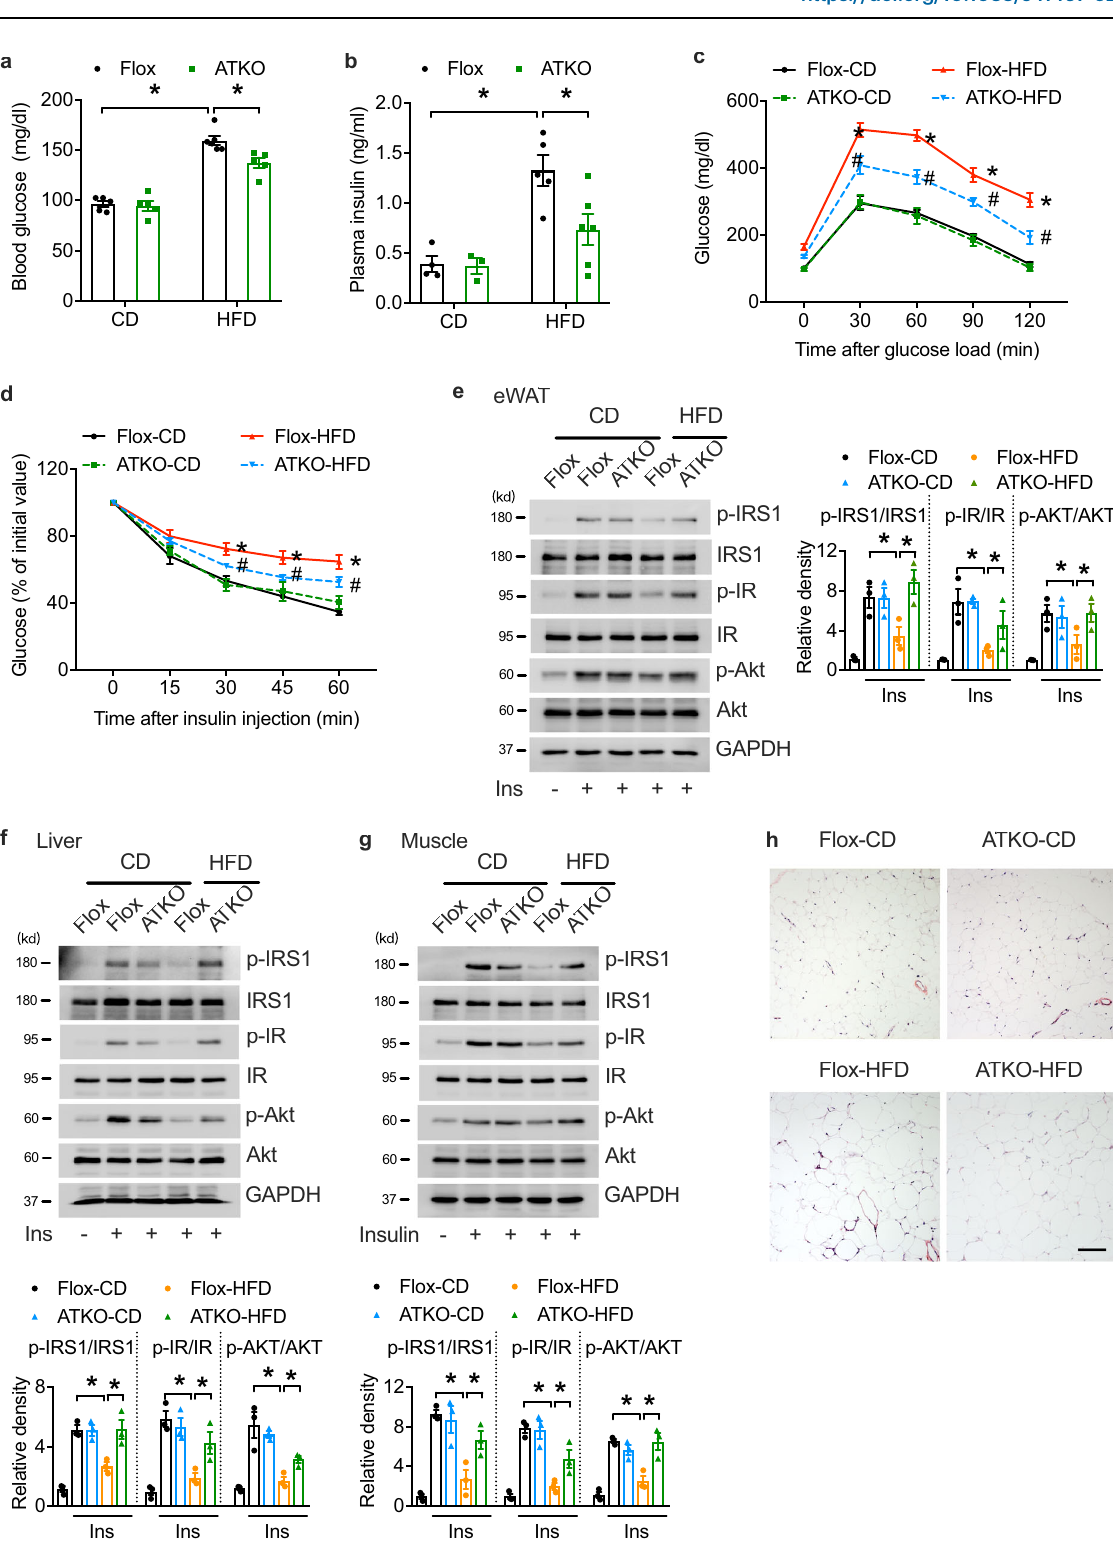
Flox-HFD. e – g Immunoblot (IB) analysis for IRS-1 phosphorylation at Tyr 612 , IR phosphorylation at Tyr 1345 and Akt phosphorylation at Thr 473 , in eWAT ( e ), liver ( f ), muscle ( g ) from Flox and ATKO mice fed with CD or HFD after i.p. injection of 0.75 U/kg insulin ( n =3 mice). h H&E staining of eWAT (scale bar, 100 μ m) of Flox and ATKO mice fed with CD or HFD ( n =3 mice). All statistical data were assessed using one-way ANOVA and are presented as mean±SEM. * p <0.05. Source data are provided as a Source Data fi le. kd, relative molecular weight in